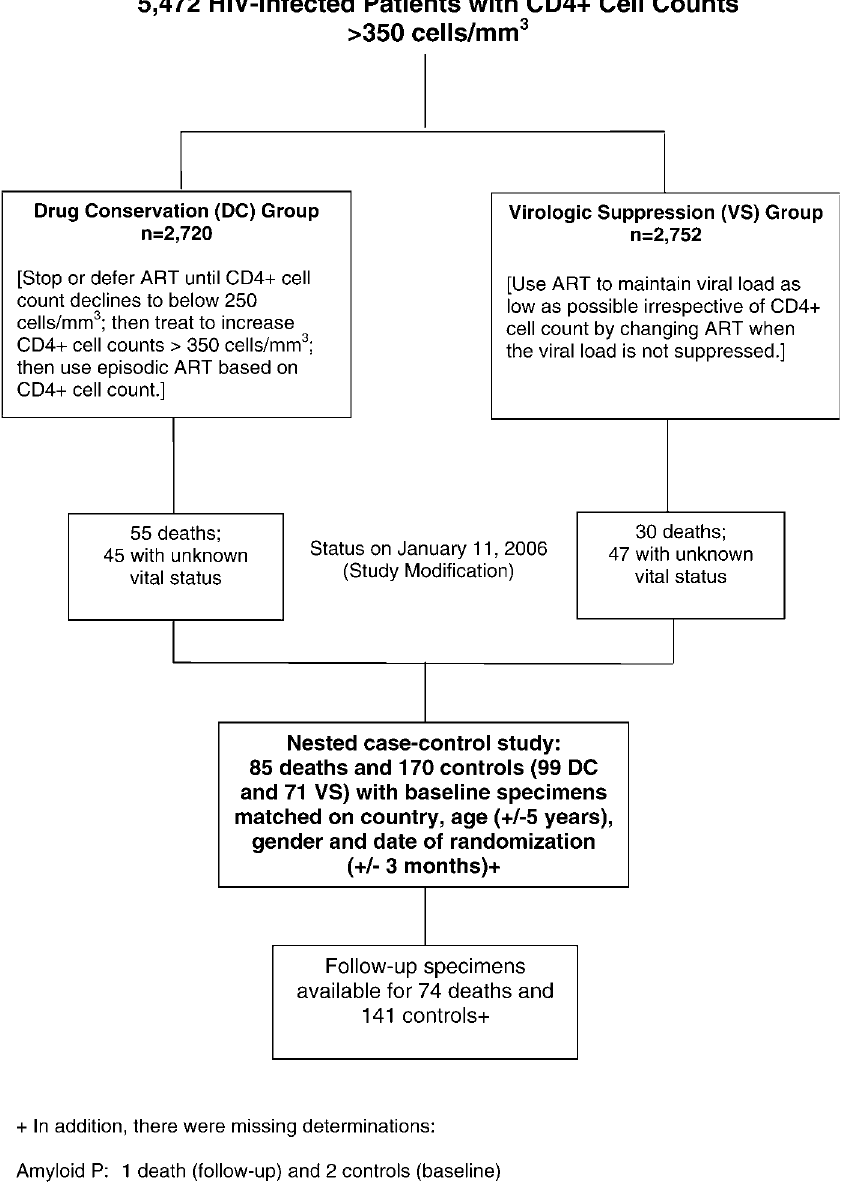
Figure 1. SMART Study Design and Flow Diagram for Case–Control